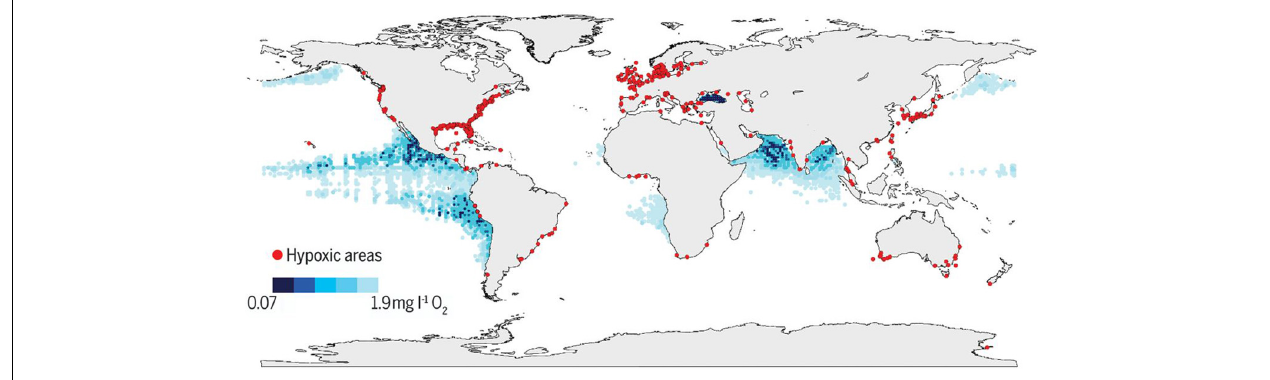
FIGURE 3 | Global map of low and declining O 2 levels in the open ocean and coastal waters from Breitburg et al. (2018). The global map indicates coastal sites where anthropogenic nutrients have exacerbated or caused O 2 declines to < 2 mg L − 1 ( < 63 µ mol L − 1 ) (red dots), as well as ocean O 2 minimum zones at 300 m (blue shaded regions). Figure permissions granted through AAAS license # 4578800750164 (accompanying documentation